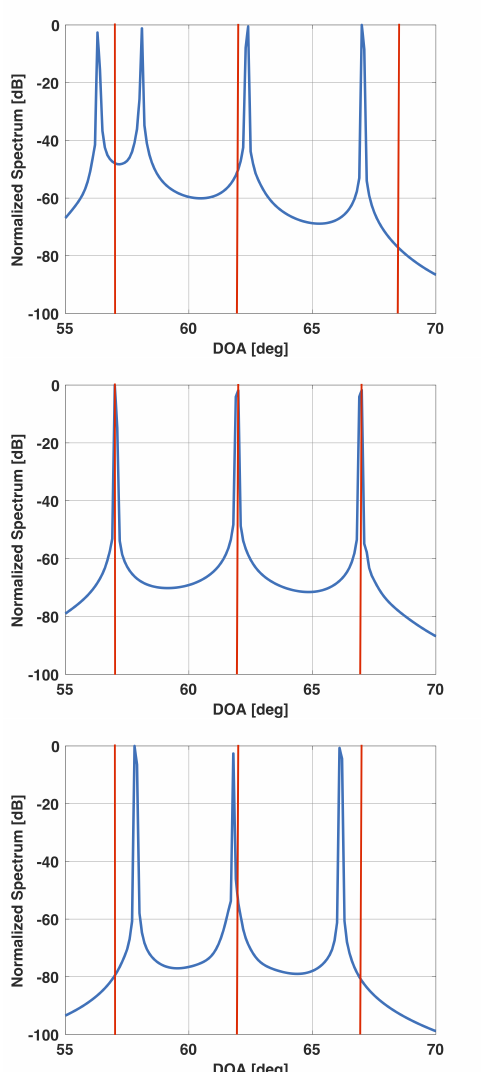
Figure 9. Solution vector x versus DOA for a uniform linear array of 15 elements in the presence of three signals at 57 ◦ , 62 ◦ , and 67 ◦ . For this scenario, β 0 = 0.0185. β = 0.02 ( top ), β = 0.0287 (selected beta) ( middle ), β = 0.1 ( bottom